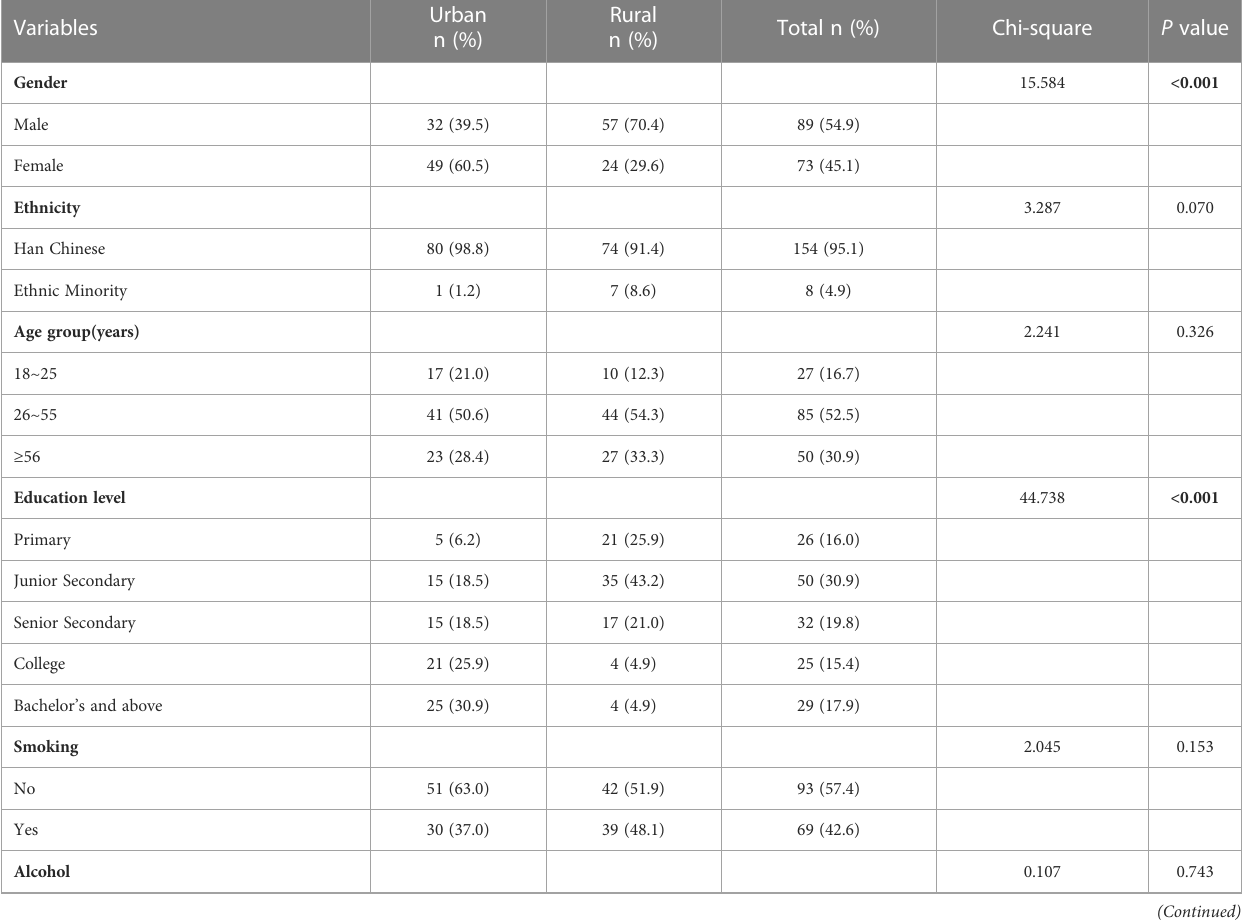
TABLE 1 Demographic characteristics of cancer